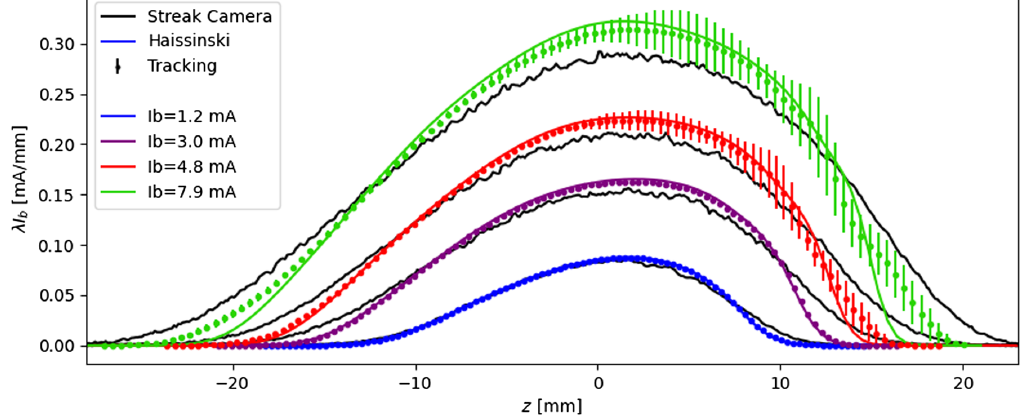
FIG. 9. A comparison between measured bunch distributions (black lines), solutions to the Haissinski equation based on the simulated short range wake model (colored lines), and tracking simulations using the same wake model